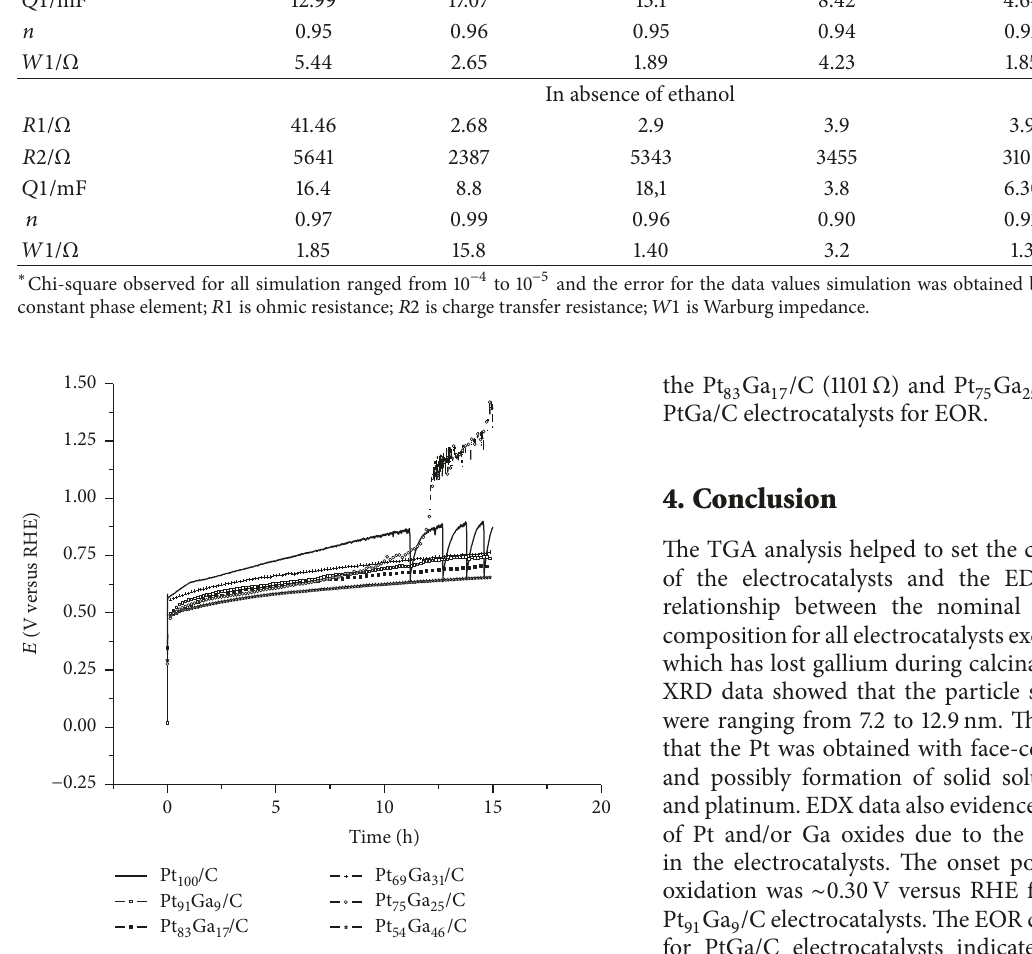
Figure 9: Chronopotentiometry of the PtGa/C electrocatalysts in 1.0mol L −1 ethanol and H 2 SO 4 0.5 molL −1 supporting electrolyte, with current density applied of 3.0 mAcm −2